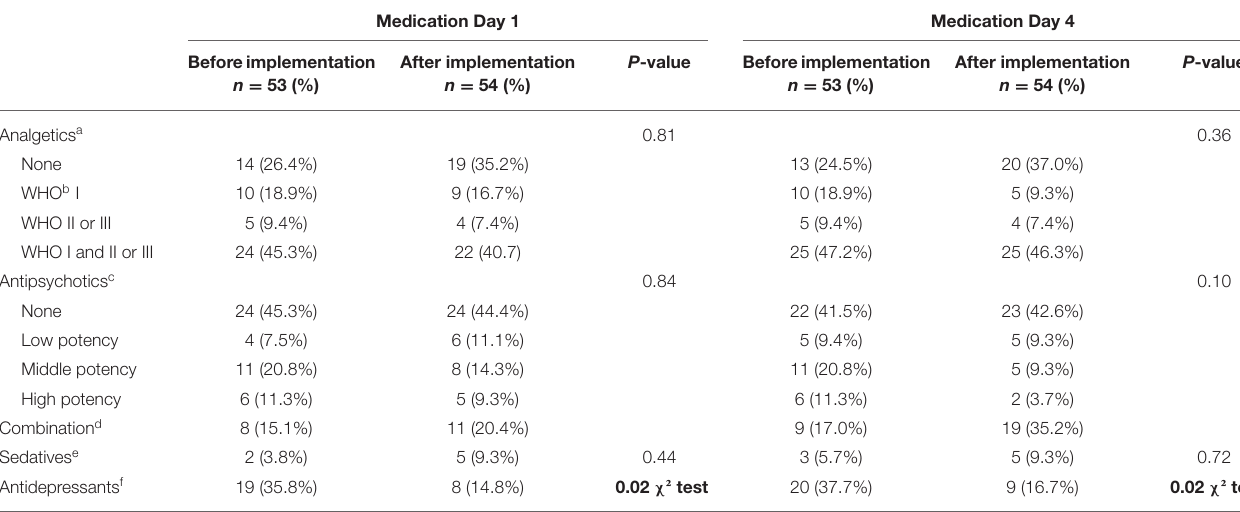
TABLE 4 | Pharmacological intervention of study participants before and after STI implementation, Day 1 and Day